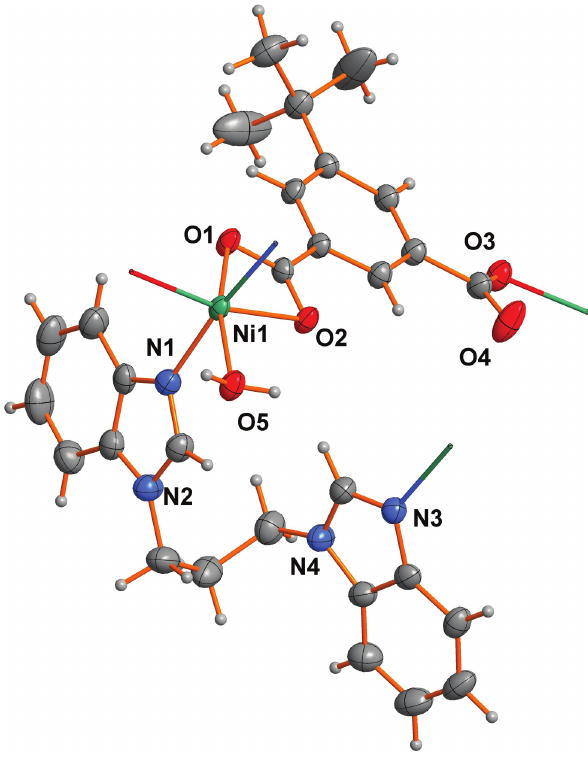
Table 1: Data collection and handling.